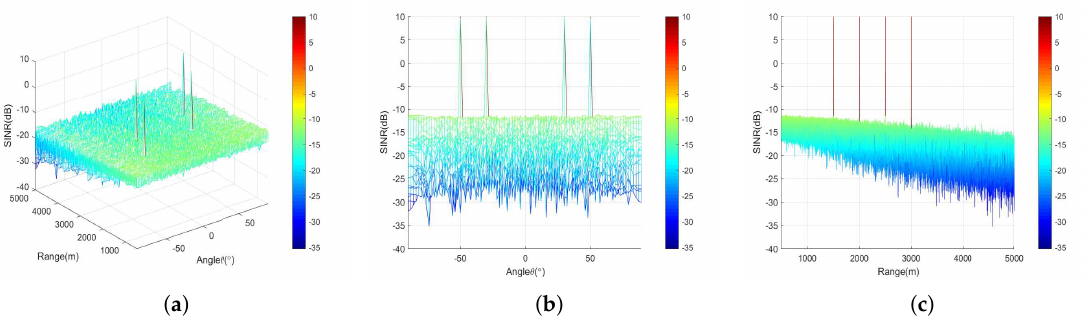
Figure 6. The signal to interference-plus-noise ratio (SINR) spatial distribution versus ( a ) angle-range, ( b ) angle dimension, and ( c ) range